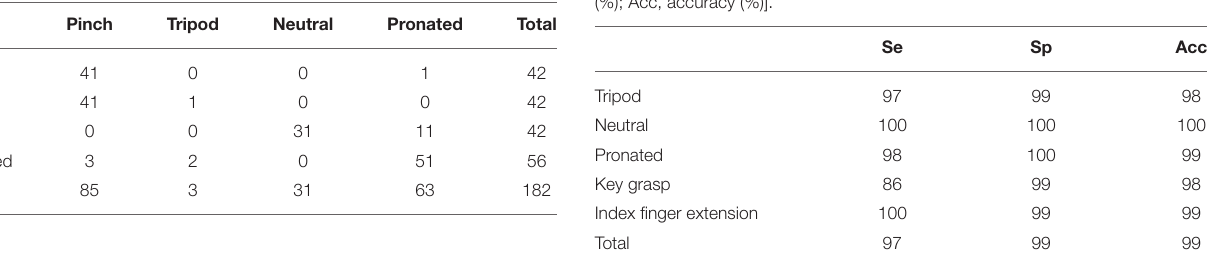
TABLE 2 | Performance metrics of experiment 1 [Se, sensitivity (%); Sp, specificity (%); Acc, accuracy (%)].